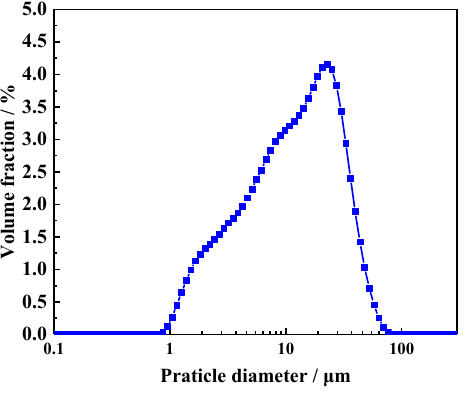
Figure 1. Particle size distribution of cement. Table 1. Chemical composition of raw materials (wt %).